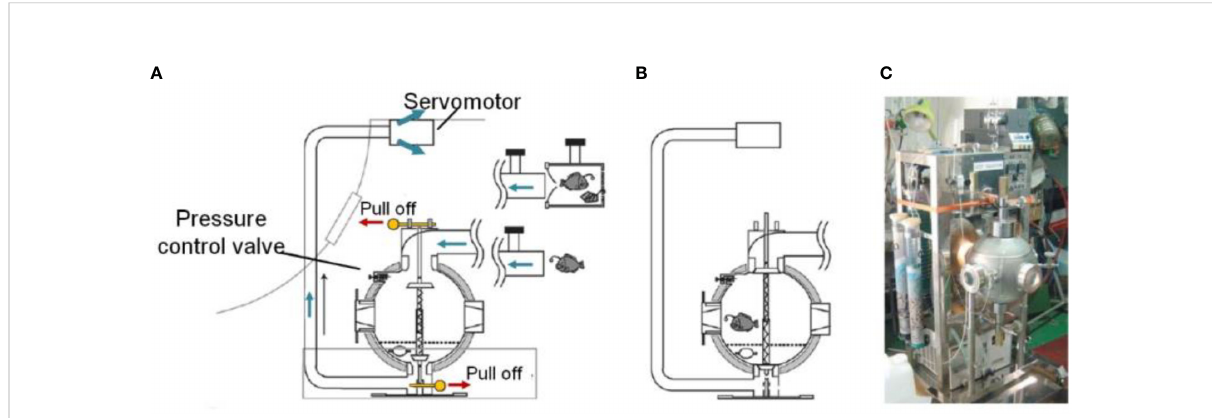
FIGURE 7 Schematic diagram and photo of pressure-stat aquarium (A) : Capture procedure of pressure-stat aquarium; (B) : Pressure vessel was sealed by the sealing door; (C) : Photo of pressure-stat aquarium (adapted from Koyama et al.,